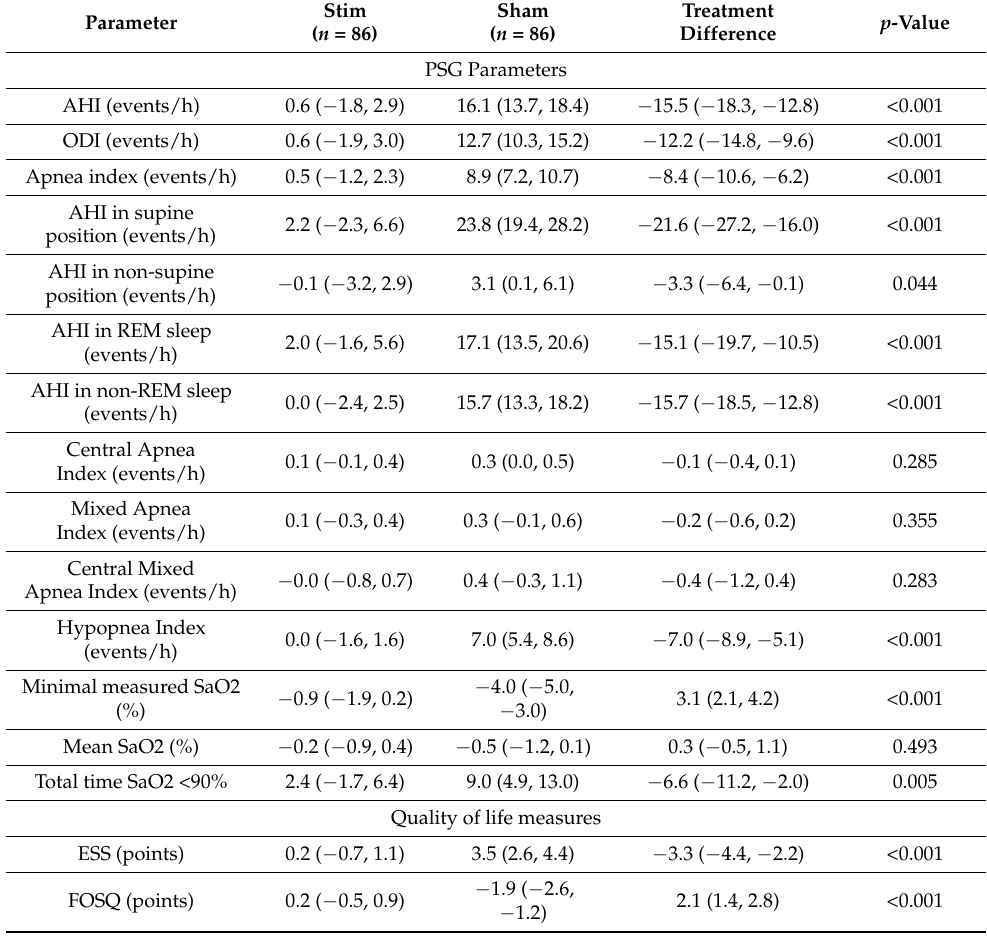
Table 4. Change from baseline between Stim versus Sham in all participants with moderate to severe